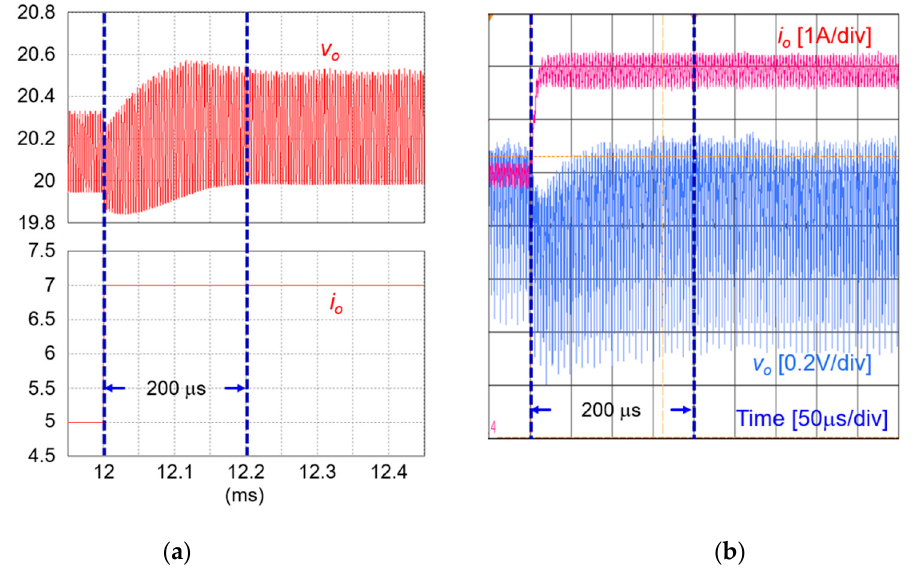
Energies 2019 , 12 , x FOR PEER REVIEW Figure 21. Transient response of load change from 50% to 70% with the mismatched secondary side leakage inductances and the flux-balance loop control ( a ) simulation results and ( b ) experiment results.